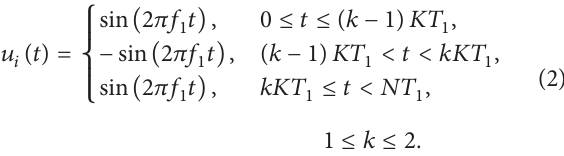
Figure 2: The waveform characteristics of amplitude impacting.